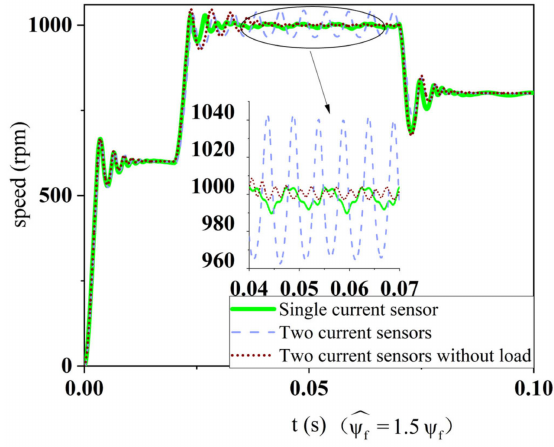
Figure 15. Mismatched speed.